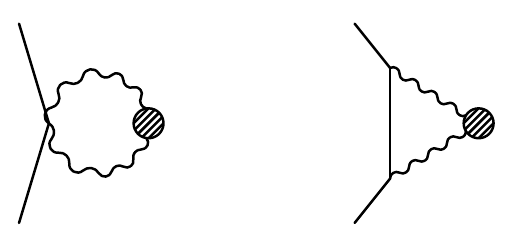
Figure 2 . Leading contributions to the one-loop scattering amplitudes. Solid lines refer to σ , while curvy ones represent gravitons. The outcoming amplitudes are suppressed by M − 4 blob represents a vertex coming from the GB term, with 2 n − 2 external scalar legs attached to